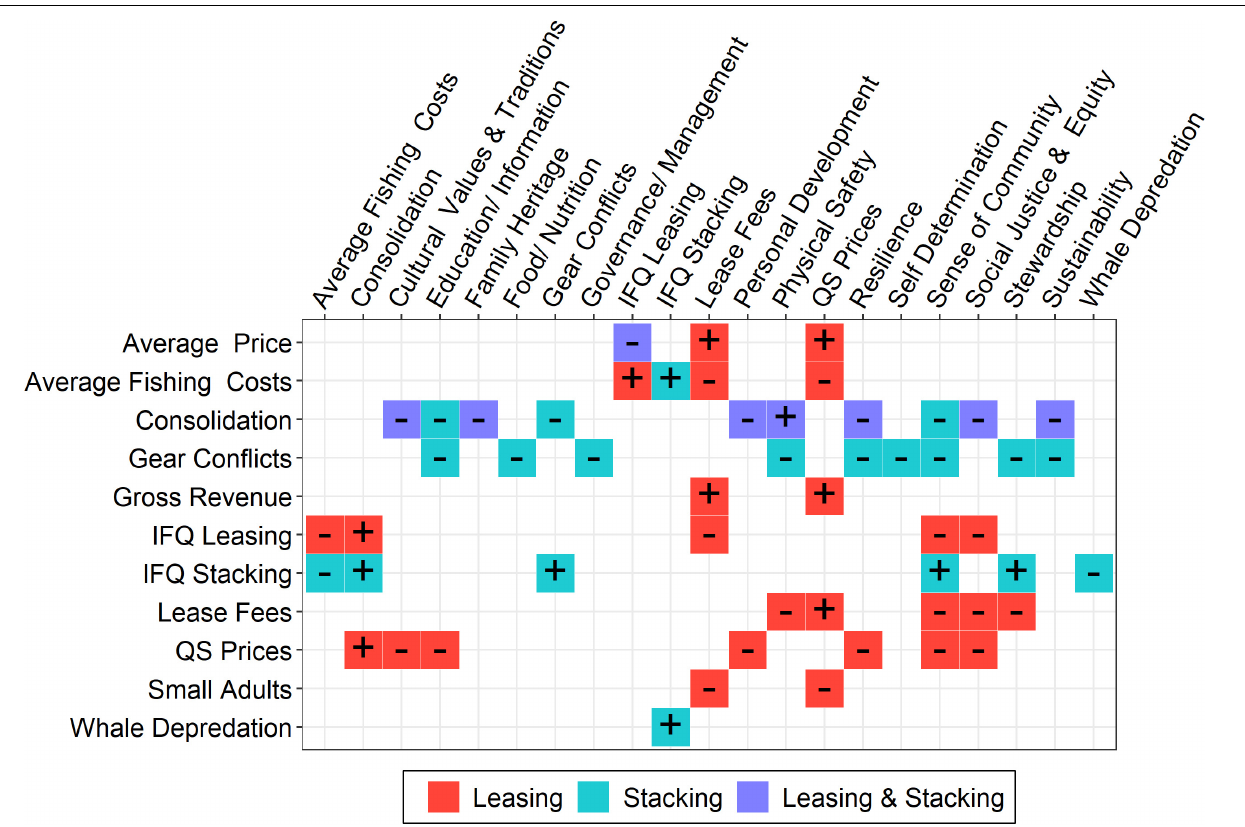
FIGURE 4 | A matrix representation of the additional variable interactions obtained from the signed digraphs specific to the leasing and stacking IFQ QNMs, derived from stakeholder interviews and literature review. All variables have a negative self-interaction (not shown). Symbols within squares indicate the link direction (+, –). Red boxes indicate links specific to the leasing IFQ model, light blue boxes are specific to stacking IFQ model, and purple boxes indicate links that are shared by both models. Figure created with R package “ggplot2” (Wickham, 2016; R Core Team, 2019). The leasing and stacking IFQ models also include all of the linkages represented in the avoidance